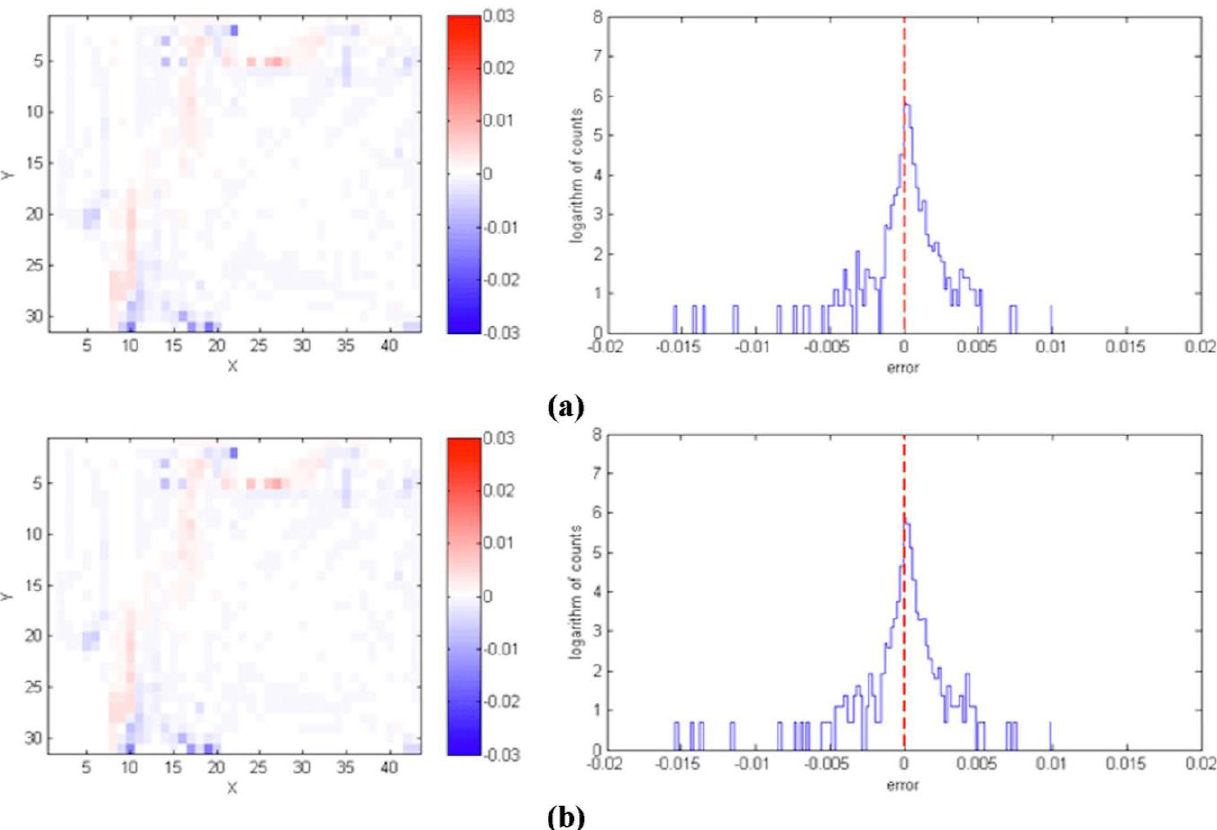
Figure 11. Comparison of the two experiments against the real data. ( a ) Agents generated from the actual counts between 8 a.m. and 9 a.m.; ( b ) Agents generated from the data for the rest of the